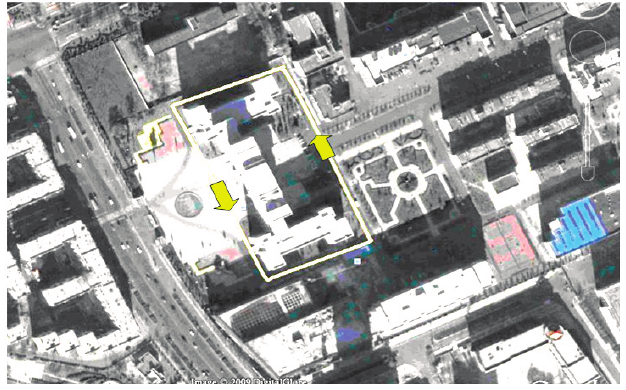
Figure 8. Testing